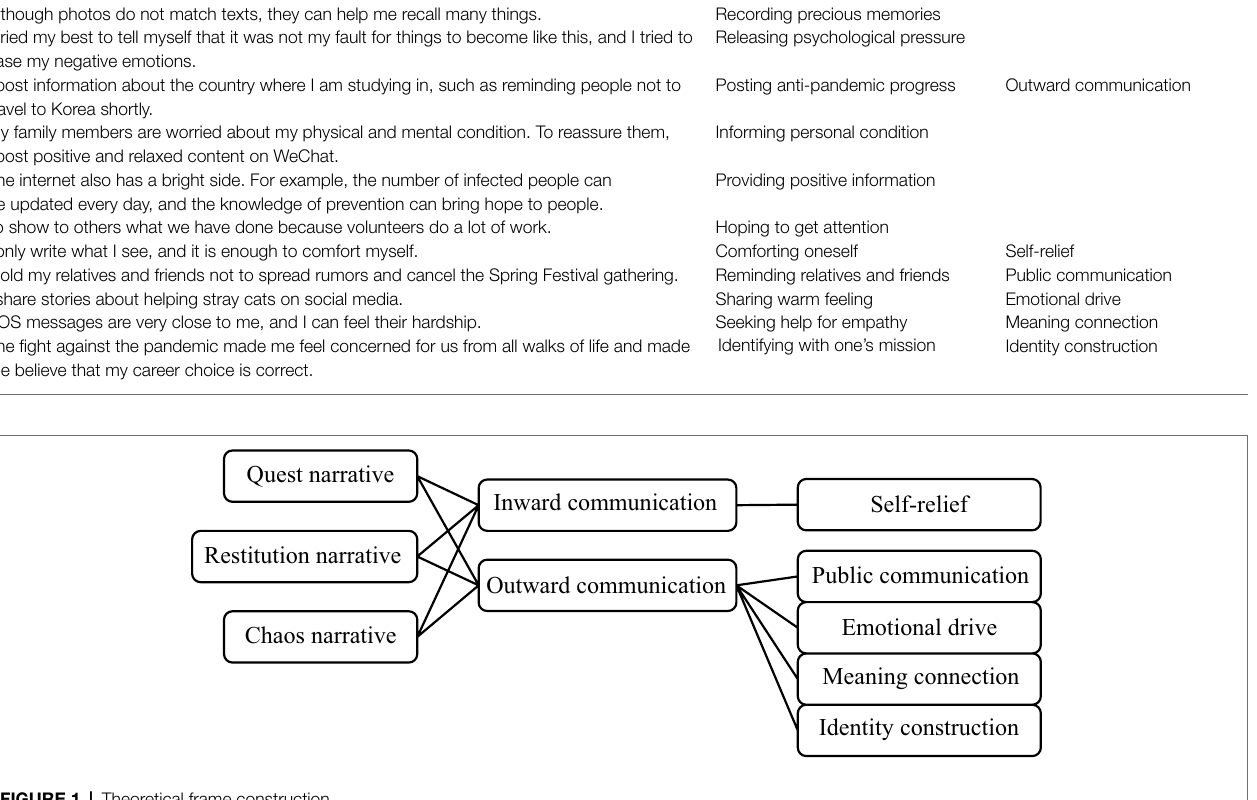
FIGURE 1 | Theoretical frame